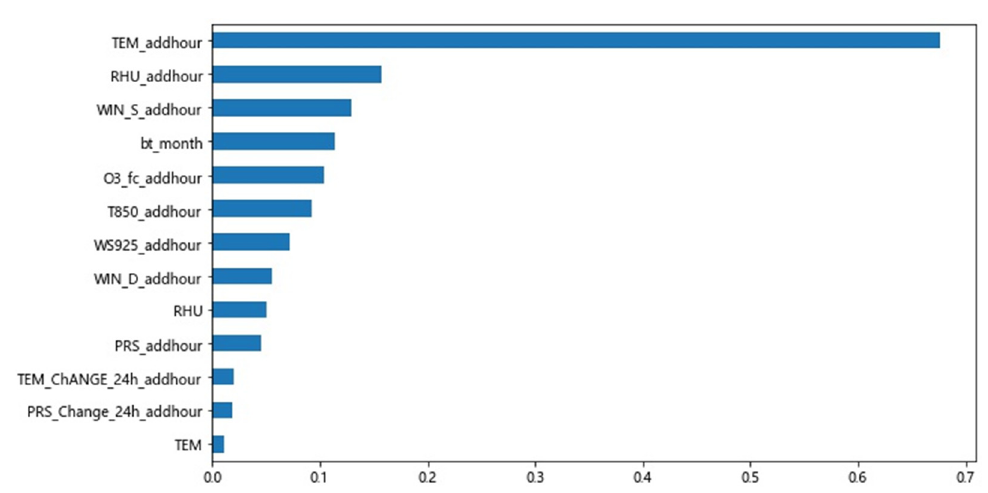
Figure 5. O 3 Characteristic factor.